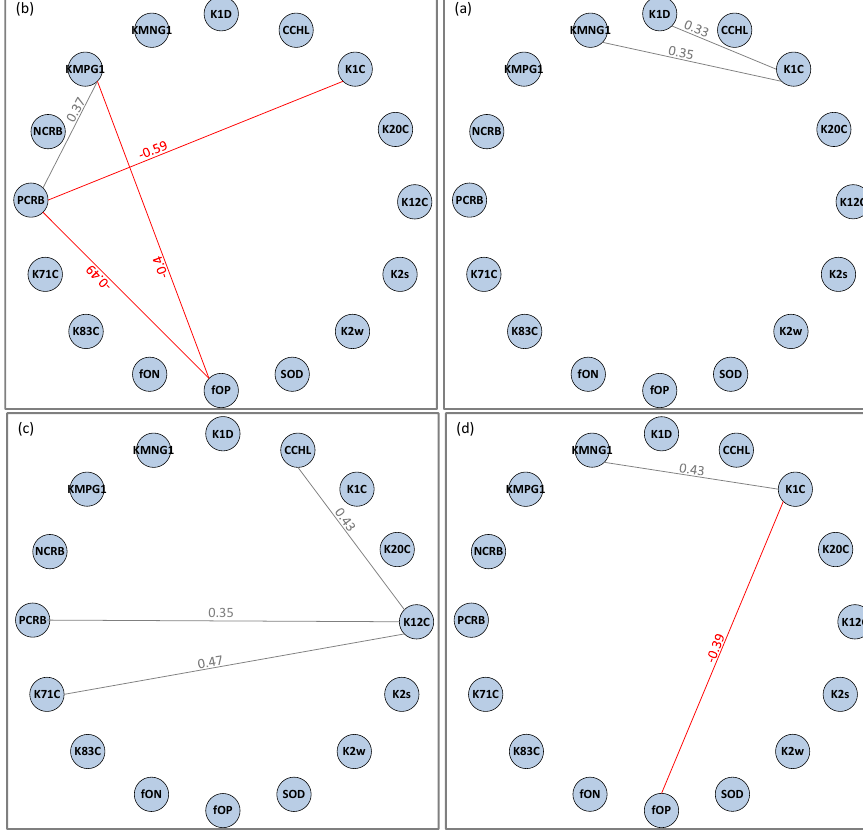
Figure 5. Parameter correlation: grey and red edges are positive and negative correlations, respectively. ( a ) uSSR at Medicine Hat, ( b ) uSSR at Leader, ( c ) lSSR at Outlook, and ( d ) lSSR at Clarkboro Ferry.